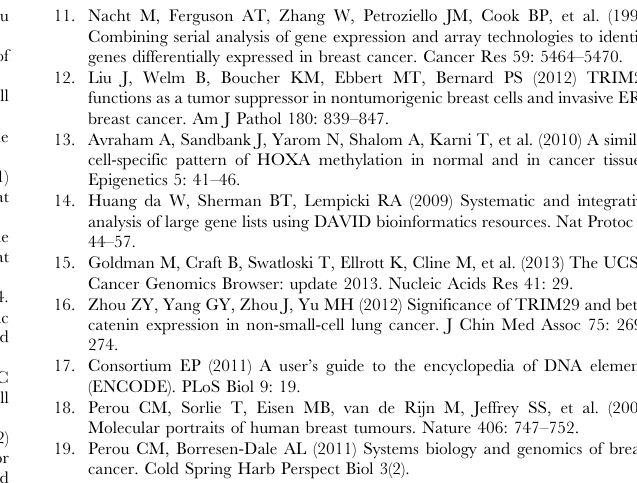
Table S5 Comparisons of TRIM29 promoter methyla- tion and gene expression for various normal tissues and respective carcinomas in